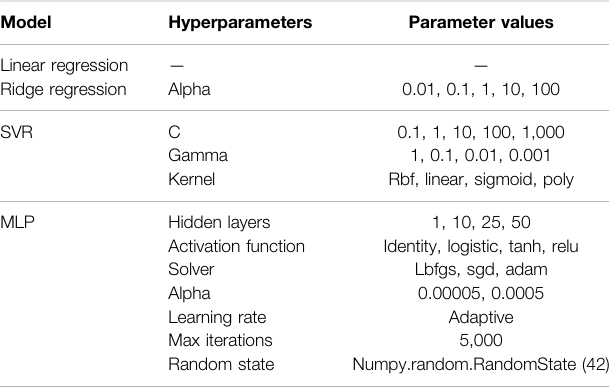
TABLE 1 | Models and parameter values used for the grid search training